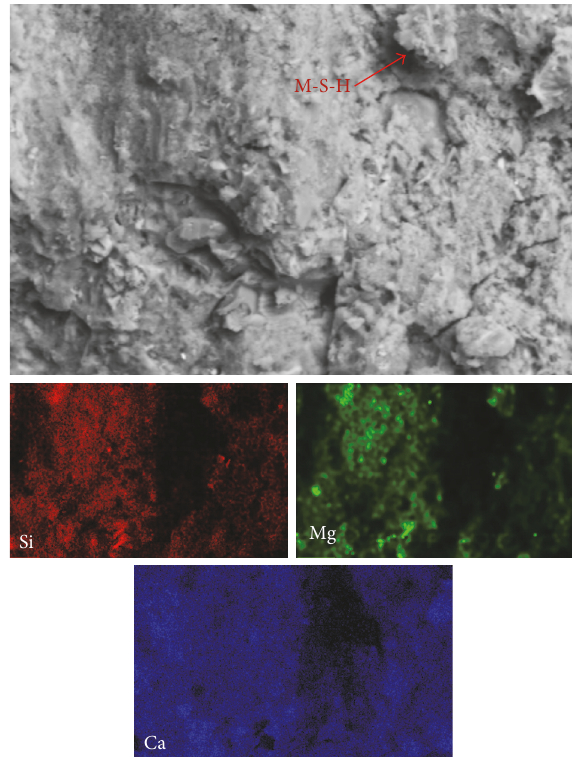
Figure 11: SEM image and its EDAX mapping on Si, Mg, and Ca of SCC-20.